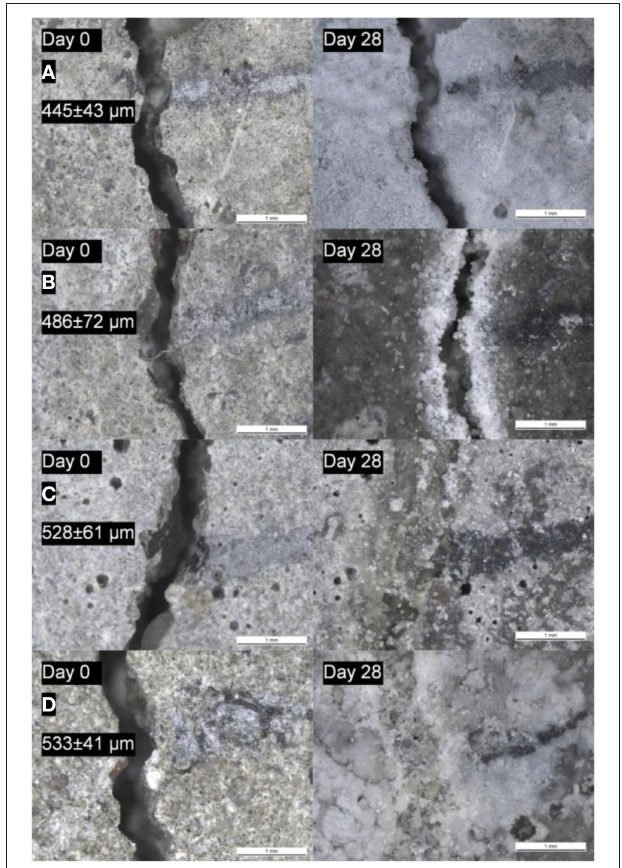
FIGURE 4 | The micrographs showing the initial (before incubation) and the final (after 28 days incubation) appearance of the cracks of the 28 days old specimens (A) reference specimen (B) abiotic control (reference + 5% nutrients) (C) specimen with 0.5% ACDC and 5% nutrients (D) specimen with 1% ACDC and 5% nutrients [N: Nutrients – 2% Ca(HCOO) 2 + 3% Ca(NO 3 ) 2 ; weight percentages are in terms of cement weight].